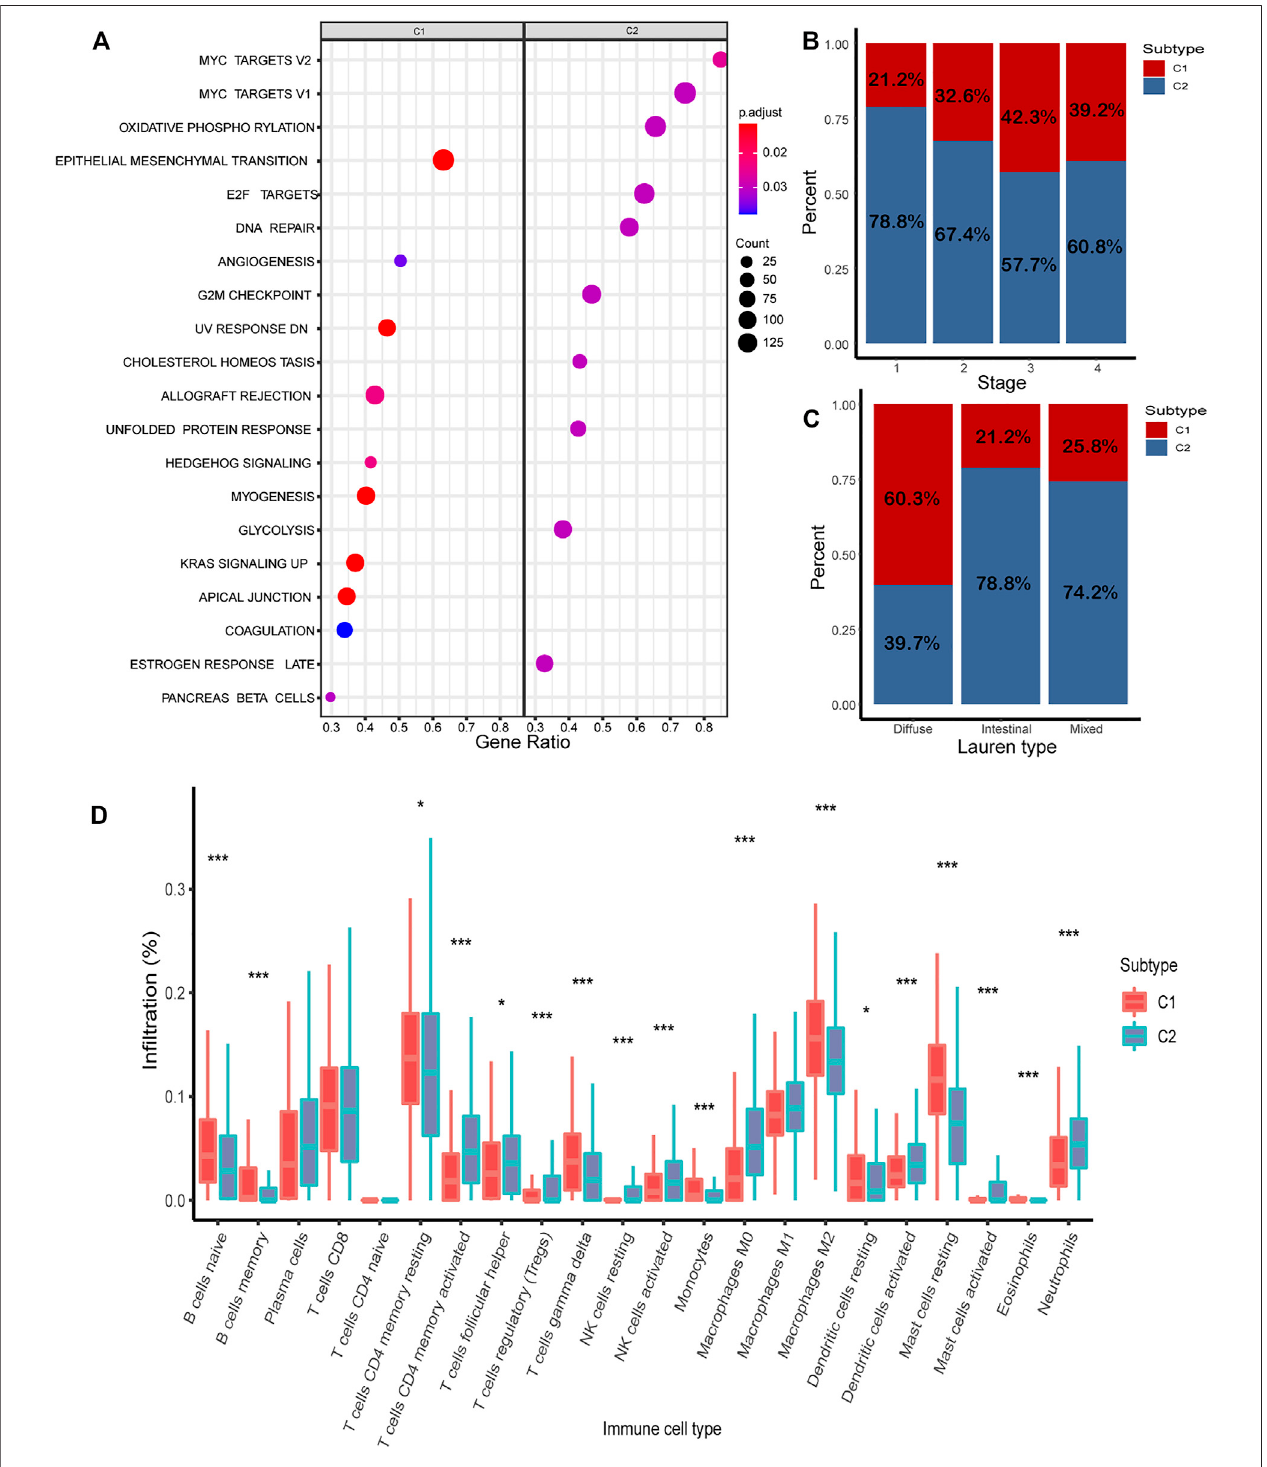
FIGURE 6 | Analysis of biological characteristics of C1/C2. (A) Highly expressed genes in C1/C2 were enriched in 20 cancer-related pathways. (B) Proportion of C1/C2 in tumor stages 1 – 4. (C) Proportion of C1/C2 in Lauren type. (D) Result of CIBERSORT in C1/C2.